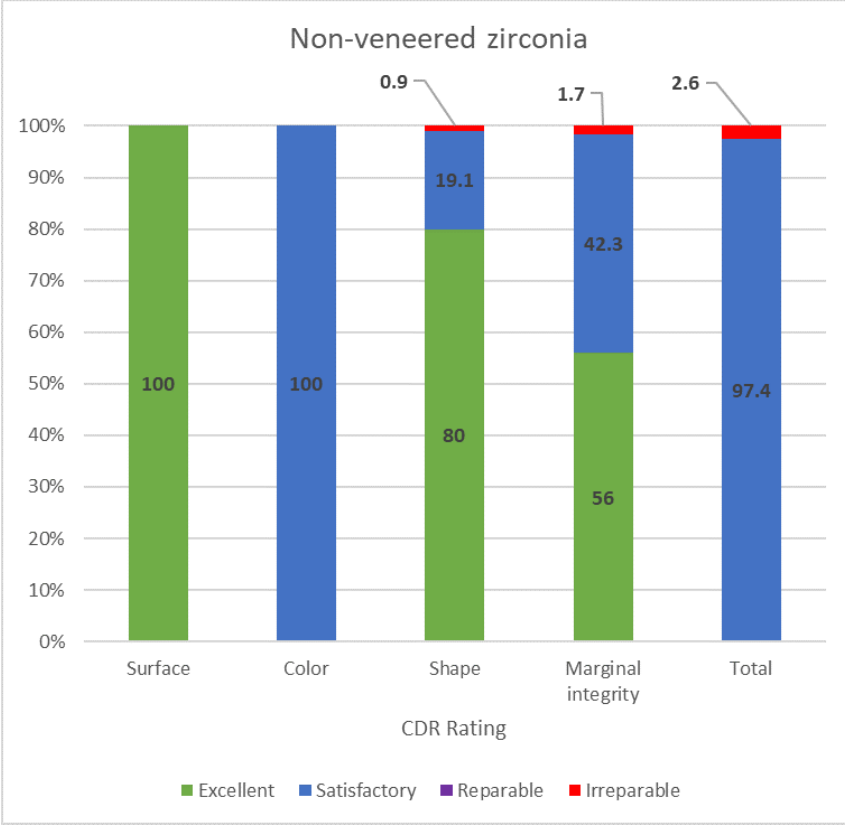
Figure 6. CDA ratings for the non-veneered zirconia group.